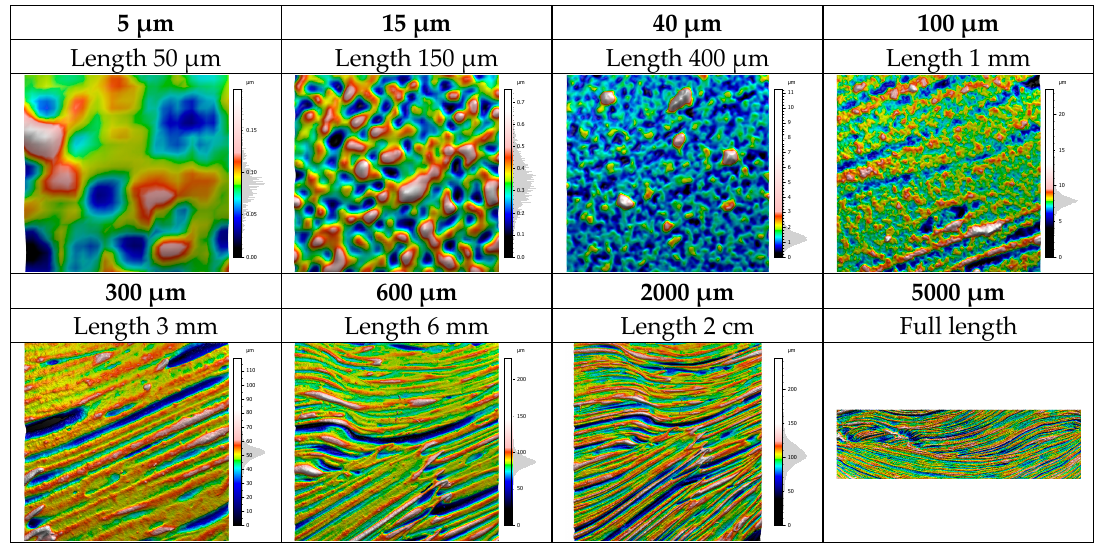
Figure 14. Principle of surface filtering (examples given with a threshold of 5, 15, 40, 100, 300, 600, 2000, and 5000 µm using a high pass filter). The full-length scale corresponds to the “optimal” filtering to appreciate the topography describing the artistic painting of all objects present on the canvas, independently of the brush stroke signature.